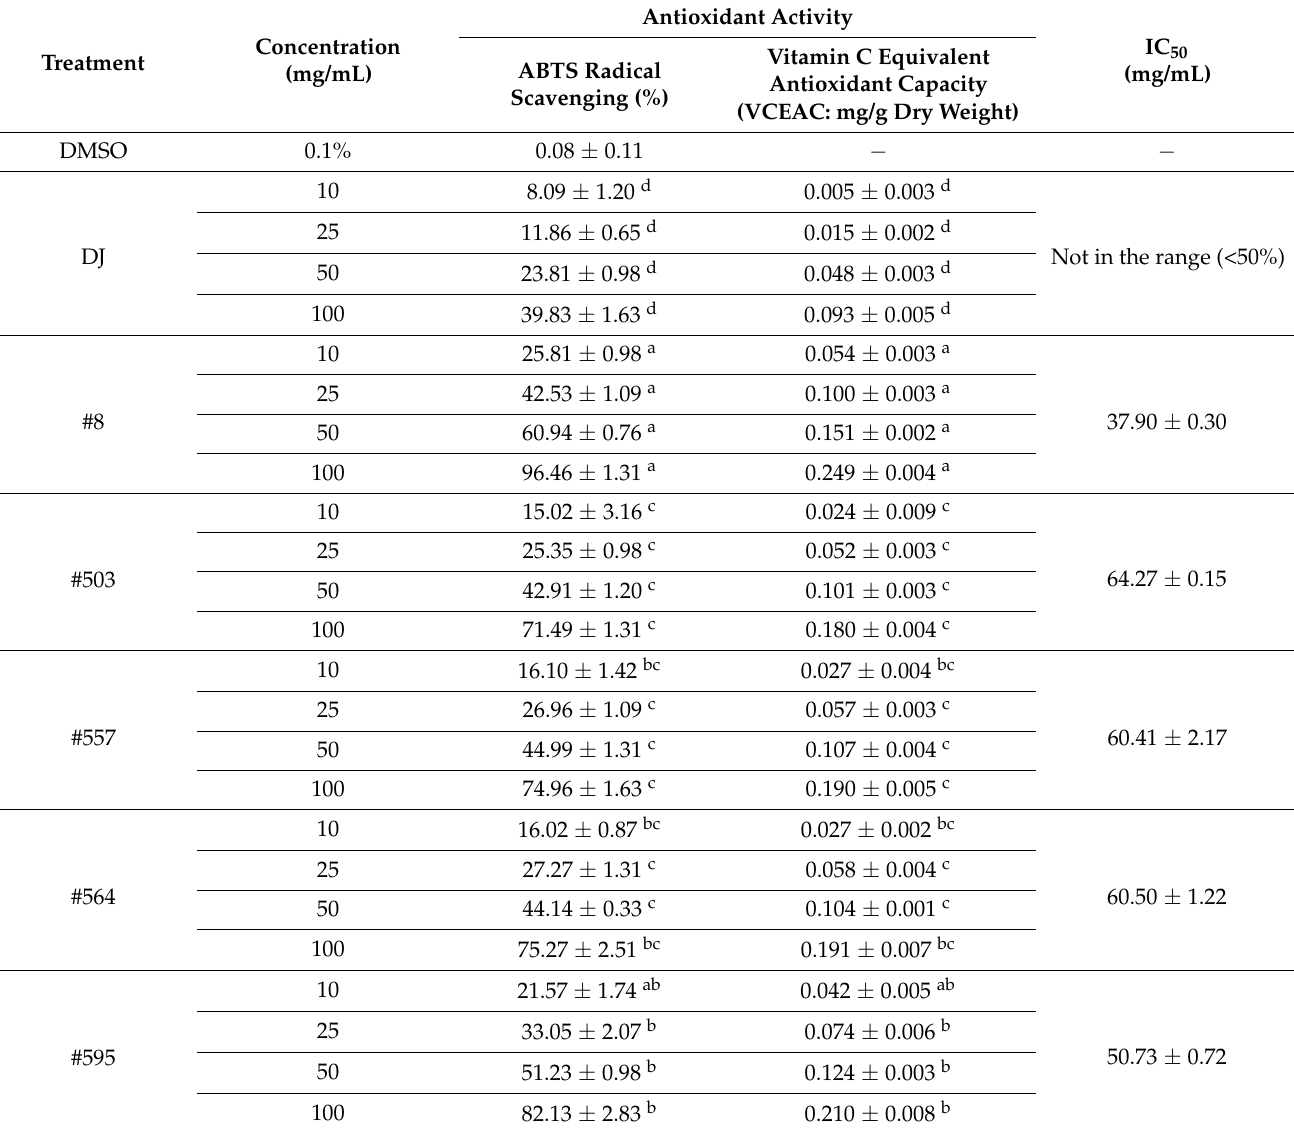
Table 2. Antioxidant activity of the PPD-enriched transgenic rice seed